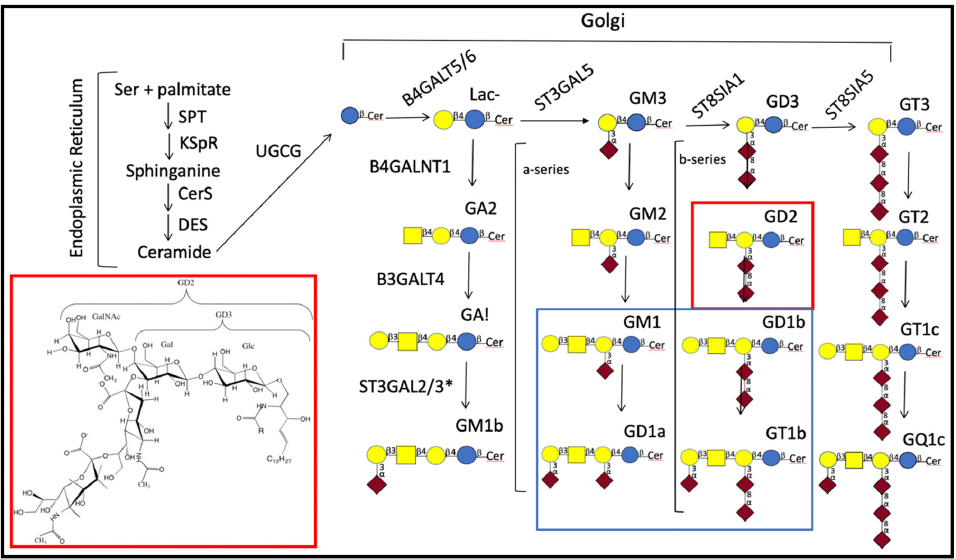
Figure 1. Synthetic pathways for common central nervous system (CNS) gangliosides. Major CNS gangliosides are enclosed by the rectangle outlined in blue and the structure and place of GD2 in